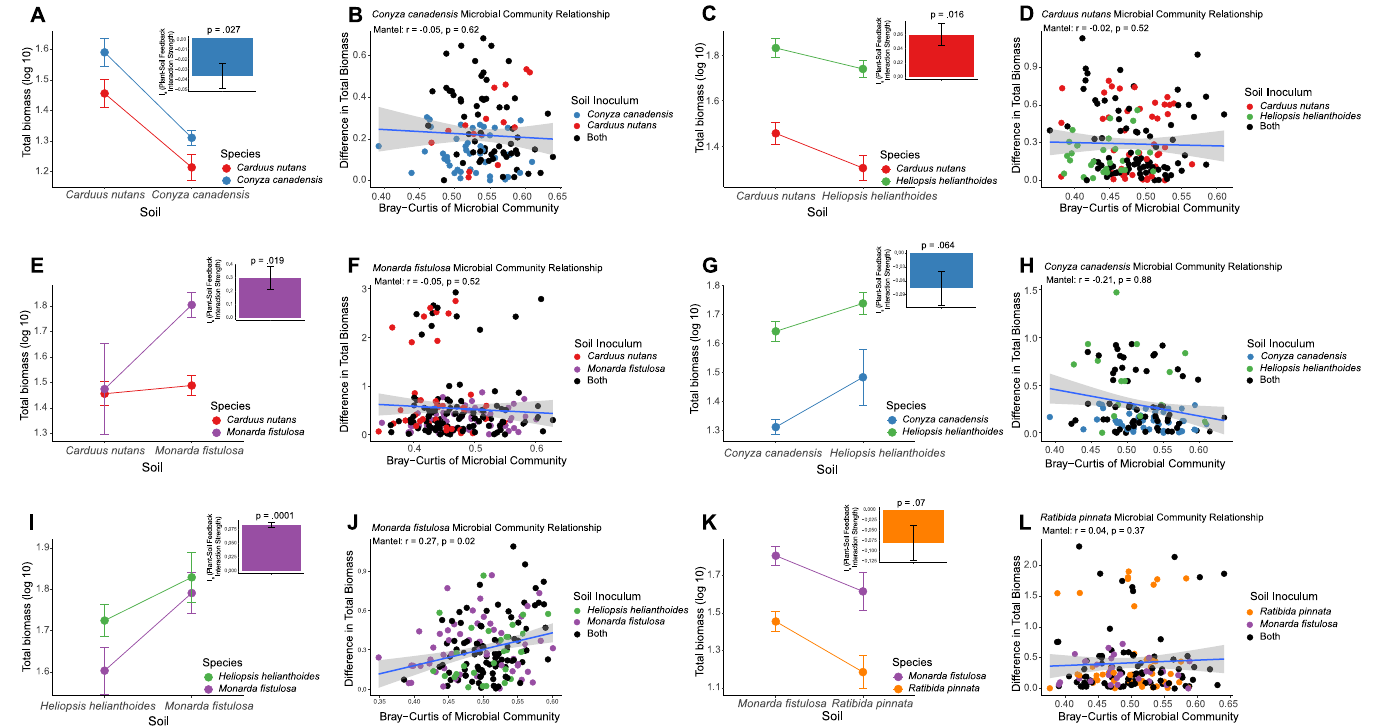
Fig 6. Significant plant-soil feedback pairs correlated with root-endophytic bacterial community composition. Plant performance when grown in soil history from conspecifics vs heterospecifics: (A) Performance of C . nutans (n = 37) and C . canadensis (n = 38). The resulting interaction between plant host and soil history defined a significant negative feedback (insert, p = 0.027). (C) Performance of C . nutans (n = 37) and H . helianthoides (n = 38). The resulting interaction defined a significant positive feedback (insert, p = 0.016). (E) Performance of C . nutans (n = 37) and M . fistulosa (n = 38). The resulting interaction defined a significant positive feedback (insert, p = 0.019). (G) Performance of C . canadensis (n = 38) and H . helianthoides (n = 38). The resulting interaction defined a closely significant negative feedback (insert, p = 0.064). (I) Performance of M . fistulosa (n = 37) and H . helianthoides (n = 38). The resulting interaction defined a closely significant positive feedback (insert, p = 0.0001). (K) Performance of M . fistulosa (n = 38) and R . pinnata (n = 37). The resulting interaction defined a closely significant negative feedback (insert, p = 0.07). Difference in total biomass grown in conspecific vs heterospecific soil correlated with difference in endophytic root microbiome composition (calculated using Bray- Curtis dissimilarity). Each point represents two individuals’ difference in root microbiome and biomass: (B) C . canadensis grown in inoculum from C . nutans vs conspecific soil (D) C . nutans grown in inoculum from H . helianthoides vs conspecific soil (F) M . fistulosa grown in inoculum from C . nutans vs conspecific soil (H) C . canadensis grown in inoculum from H . helianthoides vs conspecific soil (J) M . fistulosa grown in inoculum from H . helianthoides vs conspecific soil (L) R . pinnata grown in inoculum from M . fistulosa vs conspecific soil.